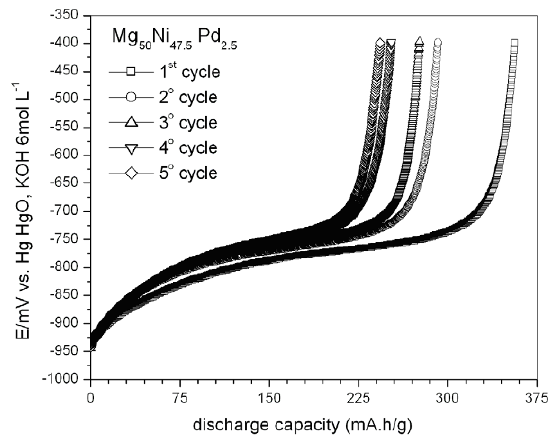
Figure 2. Curves of discharge capacity versus potential of the Mg